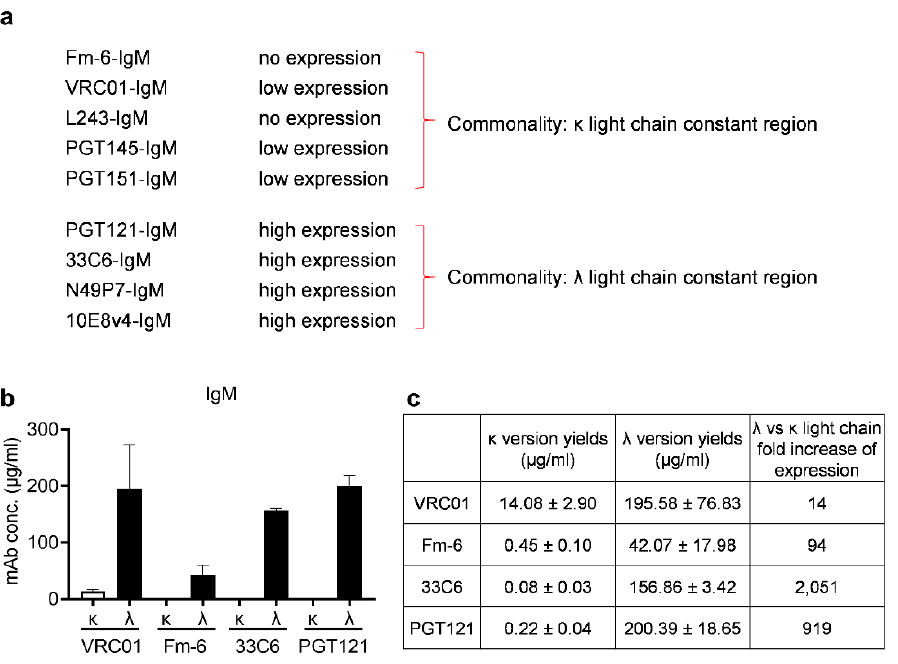
Figure 1. ELISA performed to determine κ versus λ light-chain expression of different recombinant human IgMs obtained after transient transfection in Expi293 cells. Heavy-chain, light-chain ( κ or λ ), and J-chain constructs were added for the co-transfections: ( a ) the commonality of high expression when λ light chains were paired with µ heavy chains to generate different IgMs; ( b ) the IgM concentrations in culture supernatants of Expi293 cells were determined 5 days post-transfection using ELISA. Error bars represent standard errors of the means. Data are representative of two independent experiments; ( c ) the fold difference when using λ light chains is